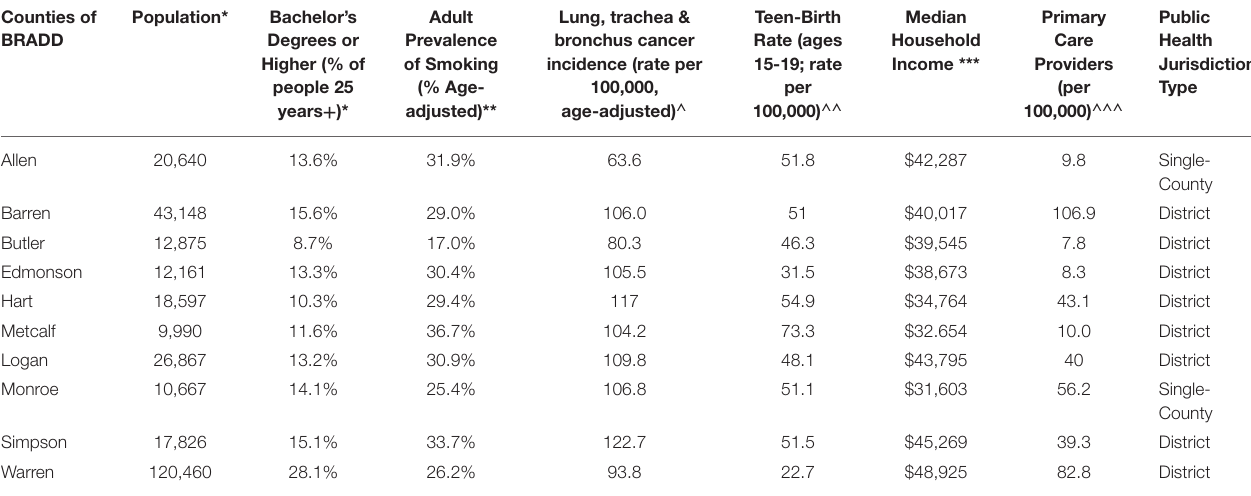
TABLE 1 | Comparison of Barren River Area Development District Counties (BRADD). Counties of